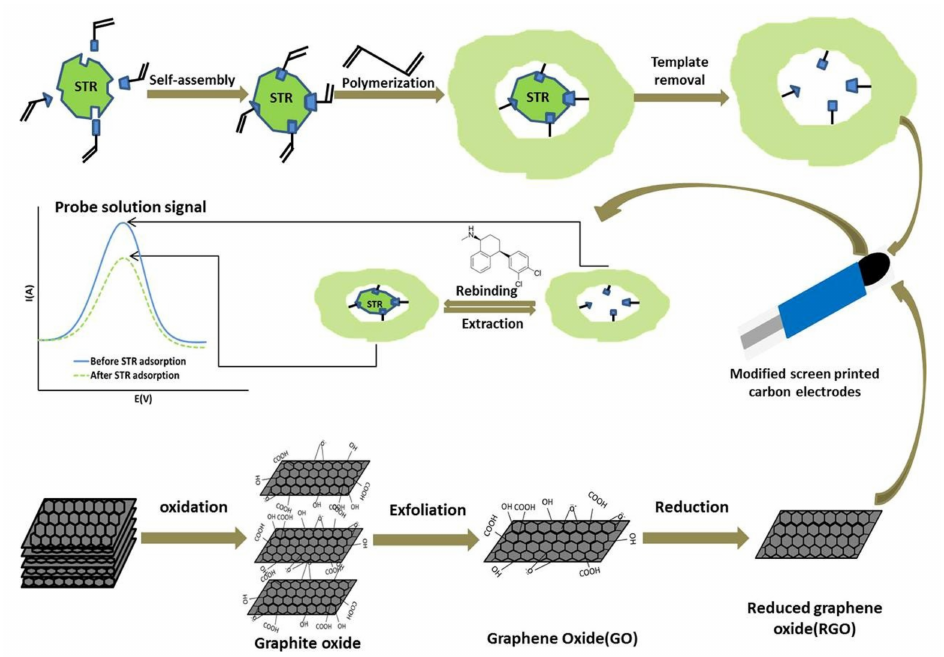
Figure 17. Modification of screen-printed electrode (SPE) with molecular imprinted polymer (MIP). Reprinted by permission from [129]. Copyright 2020